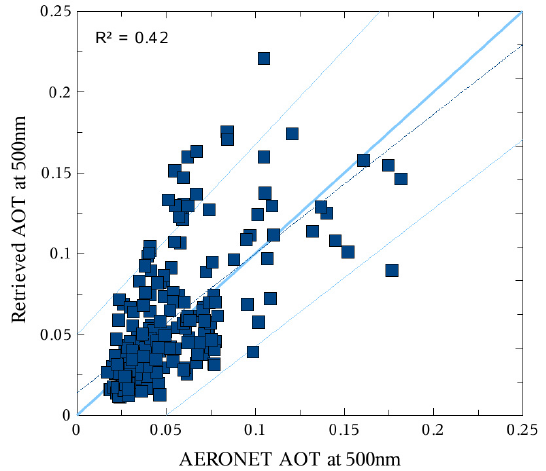
Fig. 12. Comparison of the retrieved AOTs derived from AATSR product as 3.7µm and AERONET AOTS for station Kangerlus- suaq. The solid line represents the linear regression of the data. RMSD=0.0289, R 2 =0.45.